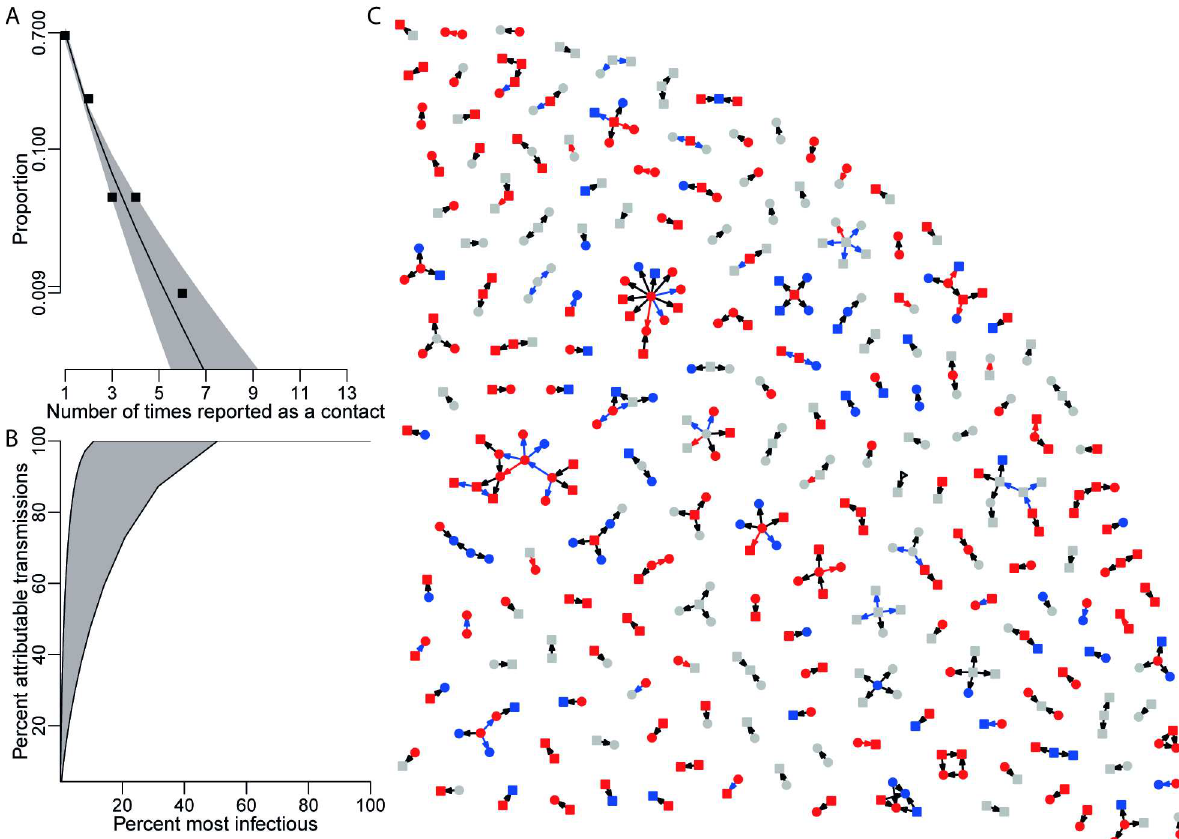
Fig 2. Contact network. (A) The out-degreedistributionof the network of exposures shows the probabilitythat a namedcontact is namedas an exposure by a certain number of cases. The squaresrepresent the observeddata. The black line shows the maximum likelihood logarithmicdistribution,with 95% confidenceinterval in grey. (B) The cumulativedensity function of the derived offspring distribution. The two black lines (edges) show two scenarios(see Figure q in S1 Text for details). (C) A sample of the network of all cases (see Figure p in S1 Text for full network) and the contacts they have namedas havingbeen exposedto. Individuals (cases and contacts) are shown as nodes, and exposuresas directed arrows from contacts to cases. Arrows are red for funeral exposures, black for non- funeral exposures,and blue for multiple exposures involvingboth non-funeral and funeral exposures.Square nodes are males, round nodesfemales, and trianglesunknown.Red nodes are cases who have died, blue nodesare cases who have survived, and grey nodes are cases with no